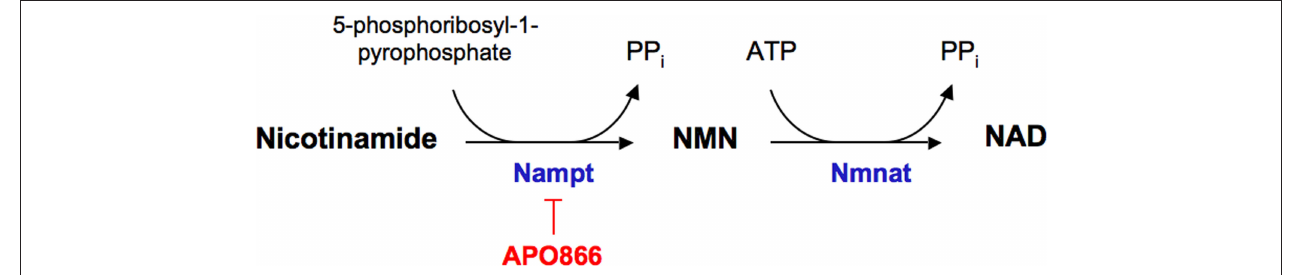
FigurE 1 | Nicotinamide phosphoribosyltransferase (Nampt) enzymatic activity. Nampt uses nicotinamide as substrate to yield nicotinamide mononucleotide (NMN). In a subsequent step, NMN can be transformed into